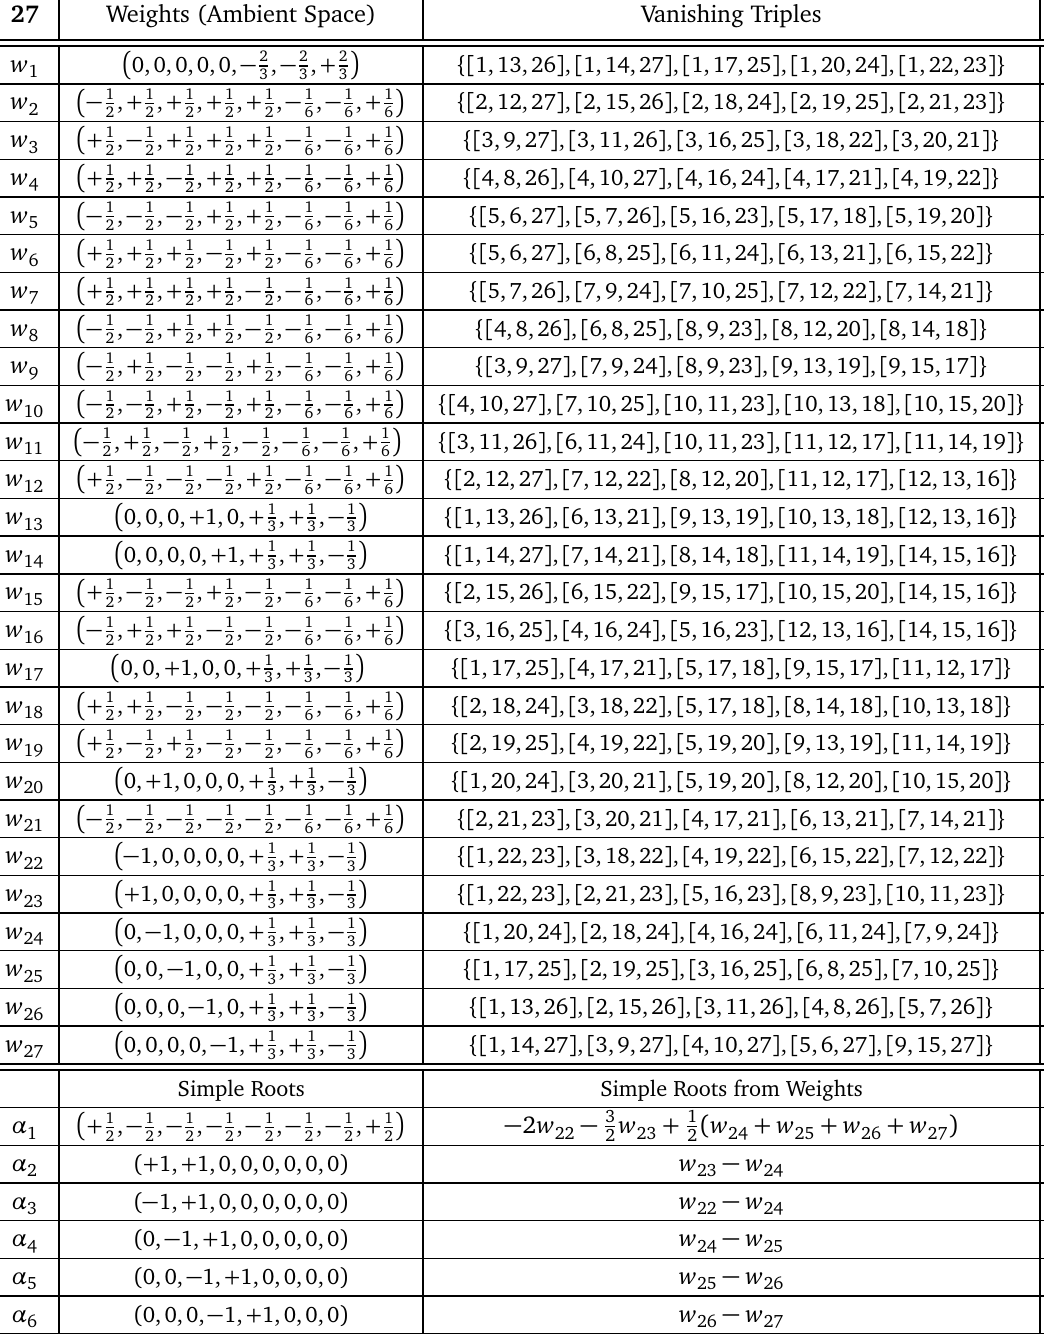
Table 14: Weights of the E resented with respect to their embedding into the weight lattice of E Space). We also give the presentations of simple roots α into